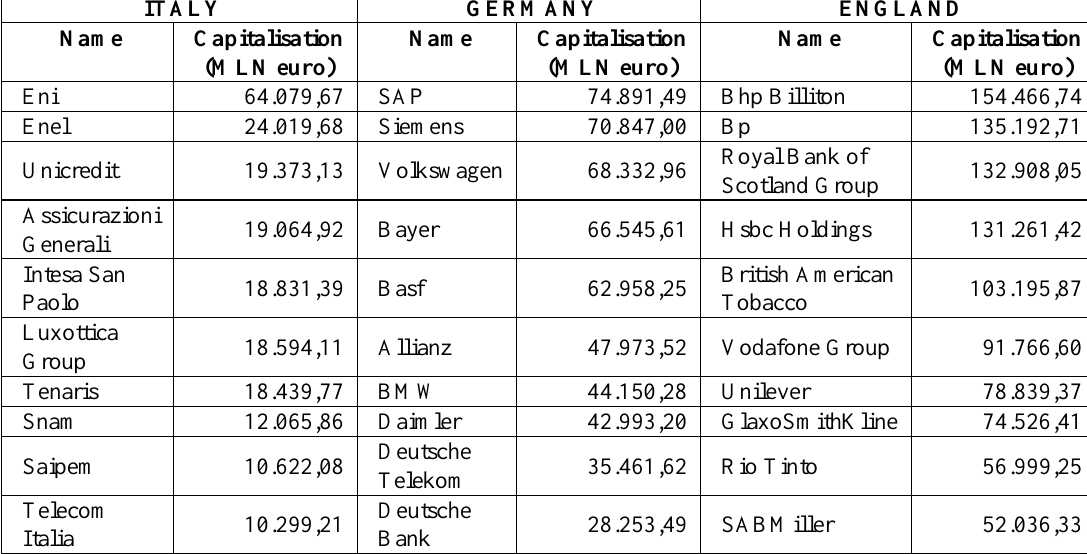
Table 1: Companies under Investigation (Capitalisation Values at 28.03.2013)